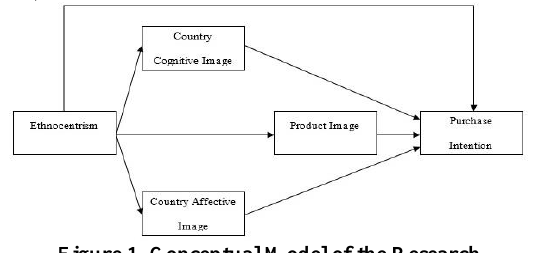
Figure 1. Conceptual Model of the